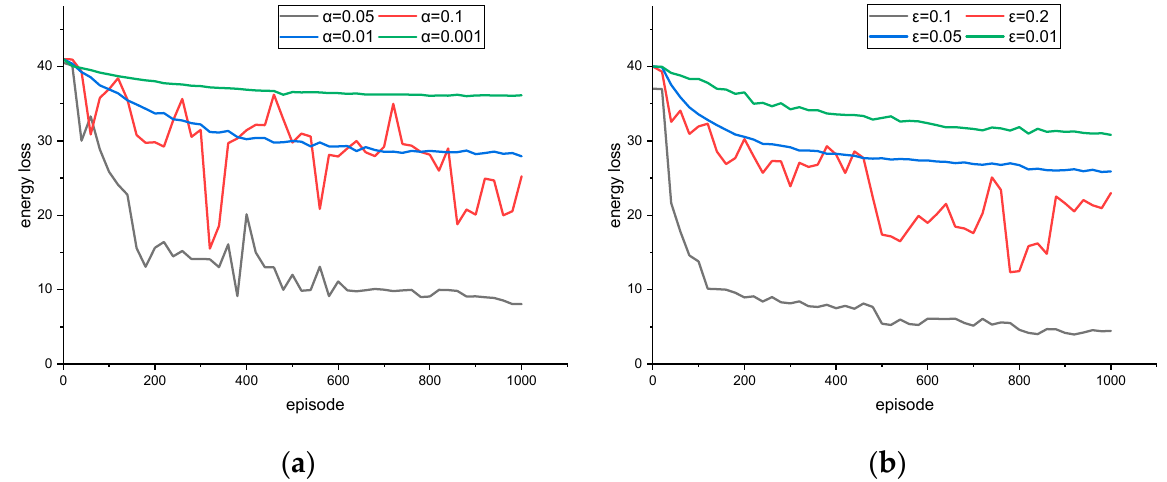
Figure 2. In order to obtain the optimal energy loss strategy, different hyperparameters were used for training energy loss with ( a ) different α ; ( b ) different ε .